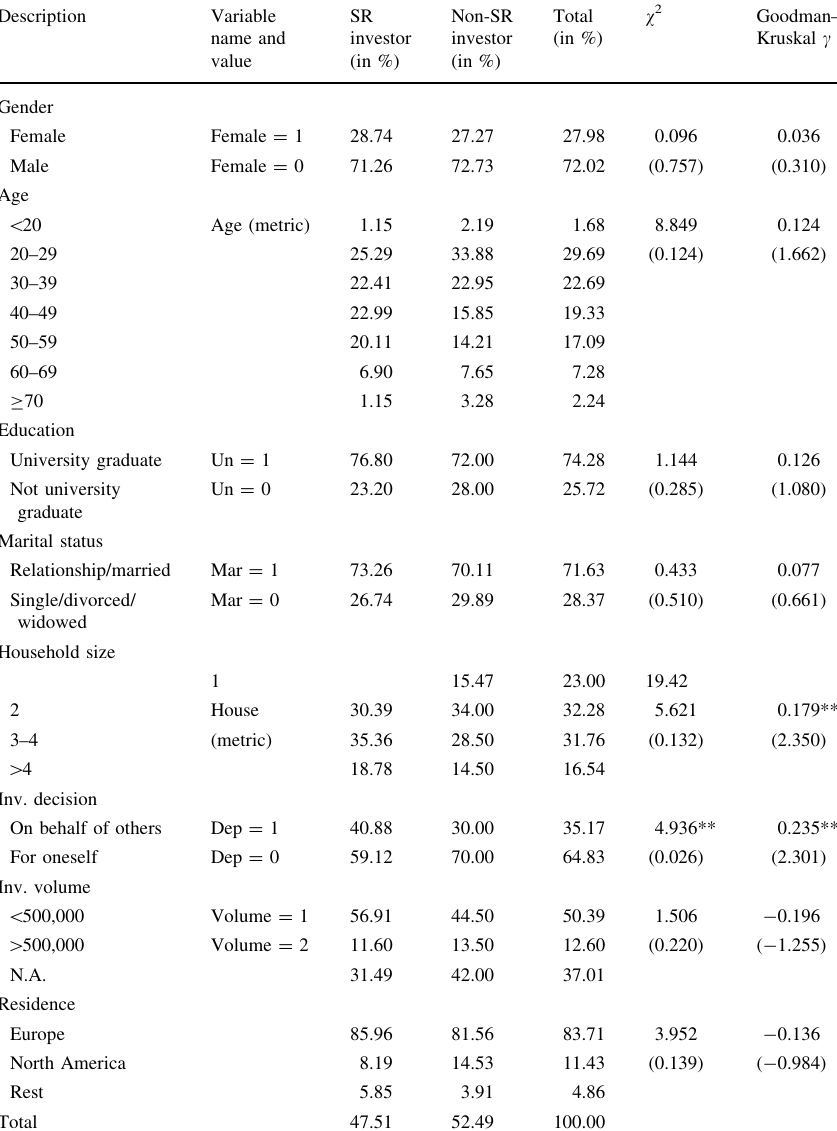
Table 1 Demographic characteristics of the survey